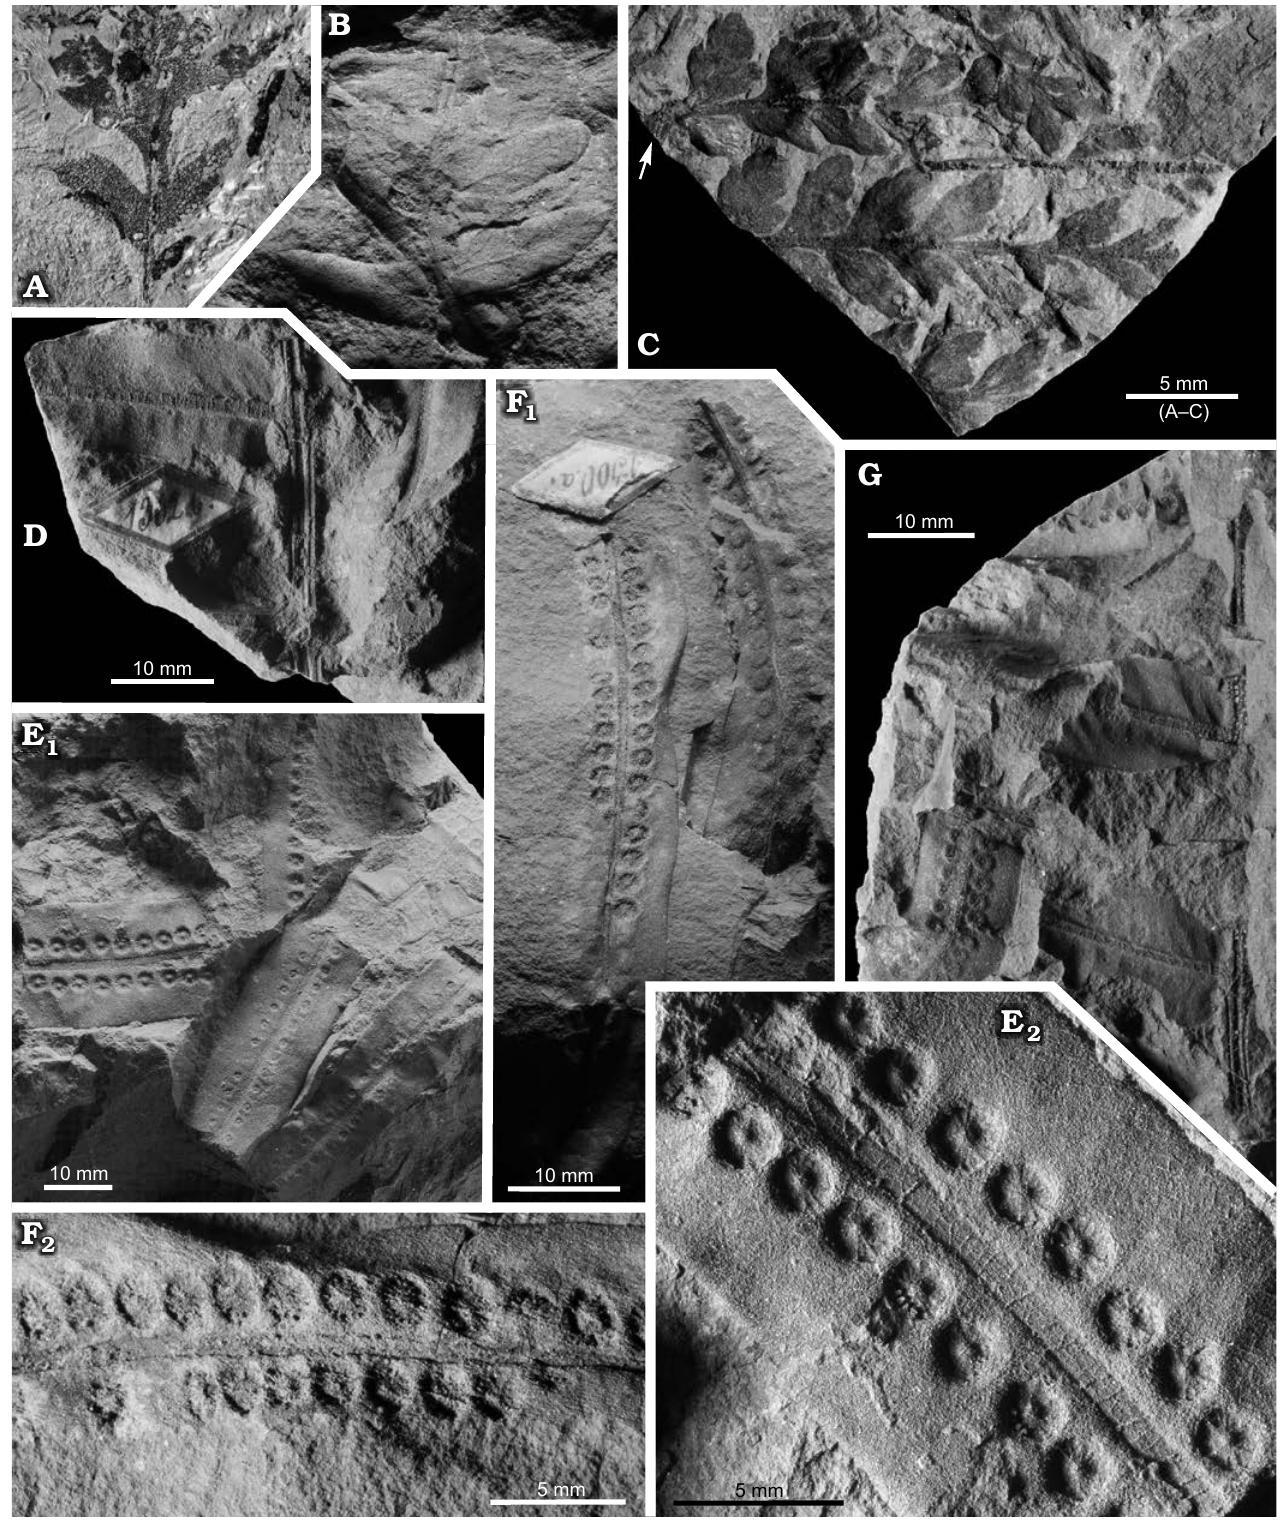
Fig. 4. Late Coniacian?–early Santonian? ferns from the North Sudetic Basin, Lower Silesia, Poland. A . Cladophlebis ? sp. 2, fragment of a pinna MGUWr 7556p, Żeliszów, Assemblage 5. B . Cladophlebis sp. 1, fragment of a pinna MB.Pb.2018/0067, Rakowice Małe, Assemblage 5. C . Coniopteris ? sp., frag - ment of a pinna MB.Pb.2018/0006 (rachis arrowed), Rakowice Małe, Assemblage 5. D – G . Konijnenburgia cf. galleyi (Miner, 1935) Kvaček and Dašková, 2010, Assemblage 4. D . Fragment of a pinna MB.Pb.2018/0062, Rakowice Małe. E . Accumulation of isolated pinnules MB.Pb.2008/373.2a (E 1 ) and enlargement of a pinnule with sori (E 2 ), Żerkowice. F . Two isolated pinnules MB.Pb.2008/373.1 (F 1 ) and enlargement of the longest pinnule in the studied material with sori (F 2 ), Żerkowice. G . Fragment of a pinna MB.Pb.2008/373.2b,